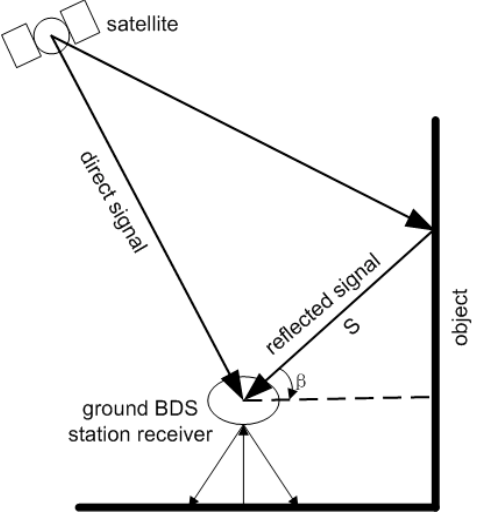
Figure 1. Principle of multipath.